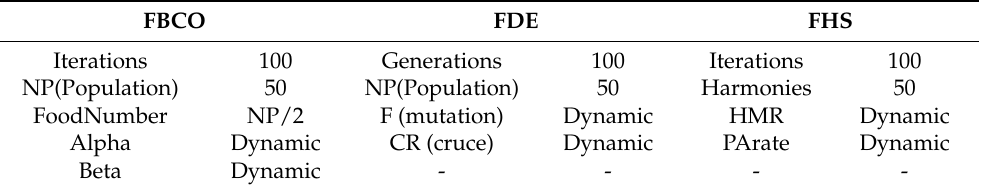
Table 5. Parameters used with the proposed methods.